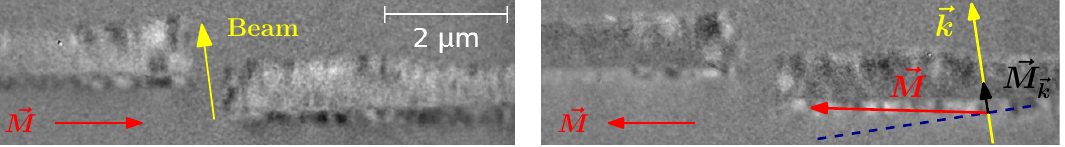
Fig. 12: Magnetic switching of annealed tubes with axial magnetization . The magnetization in the axially-magnetized tubes can be reversed by applying field along the tube axis, as seen from the left to the right image. The beam arrives from the bottom of the image, and is close to perpendicular to the tube axes, so that the pro- jection of magnetization to the beam direction is small. This leads to weak magnetic contrast. Still one can distinguish the switch, both on the tube and in the shadow. In both images the left tube displays some azimuthal curling close to its end, as seen in the shadow. Both tubes display several defects (holes) due to